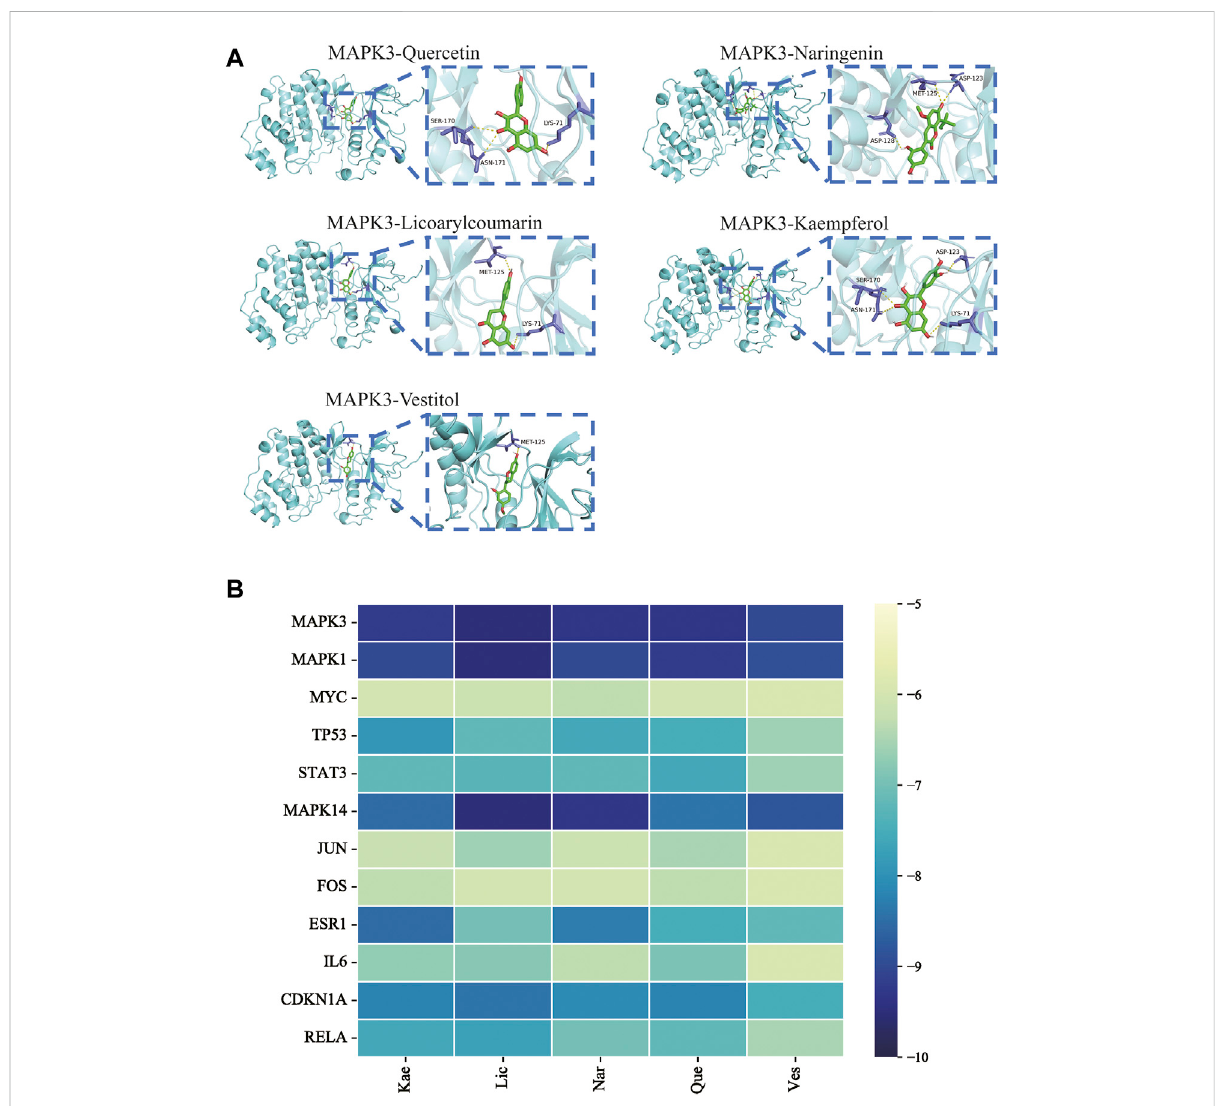
FIGURE 4 Validationofmoleculardocking. (A) Representativemoleculardockingmodediagram. (B) Heatmapofbindingbetweenkeyactivecomponents and intersective hub